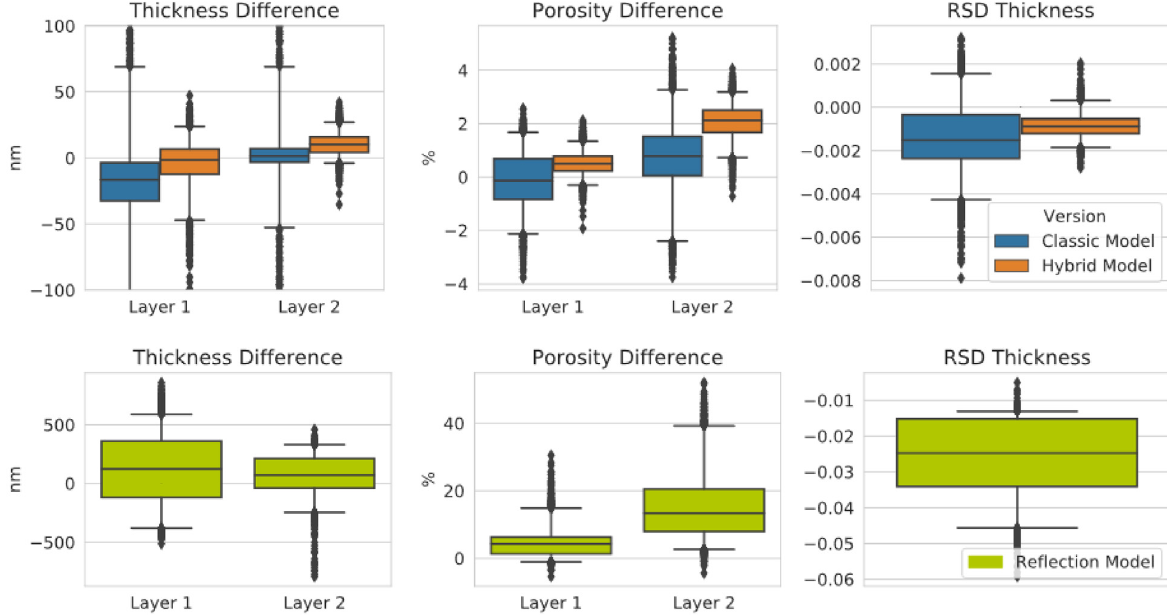
Fig. 6. Boxplot of the difference between the model prediction and the actual layer parameters for all three models (different colours). Since the performance of the re fl ection model is signi fi cant worse than for the other two, the results are displayed separately. Table 1. Display of the mean relative error (MRE) of the layer parameters predicted by the classic and the hybrid model.